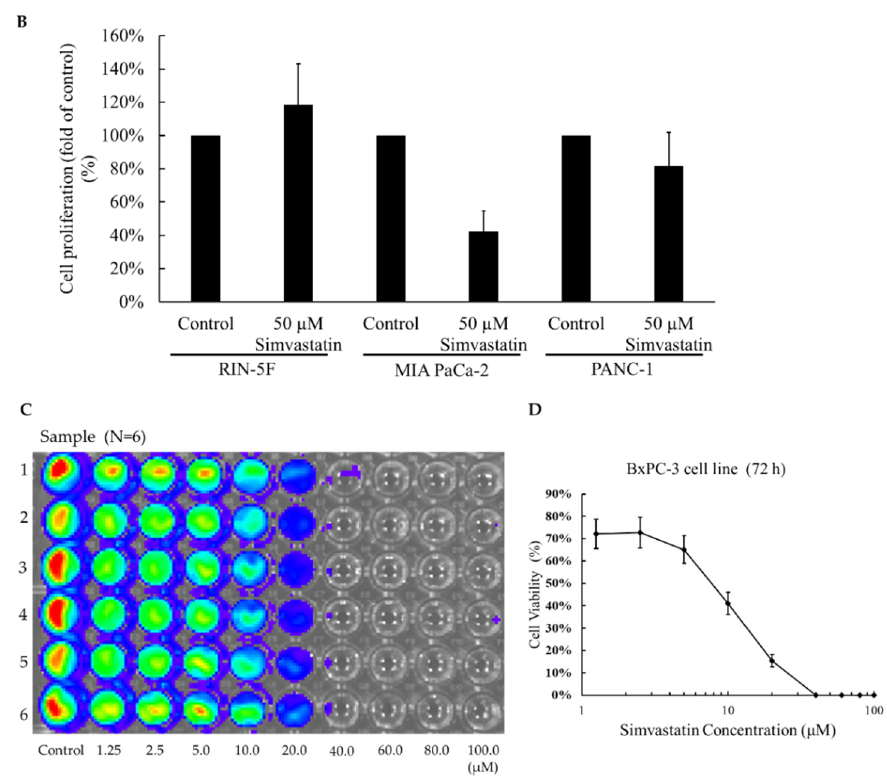
Figure 1. The pancreatic cancer cell viability after simvastatin treatment. ( A ) 50 μM simvastatin treatment significantly decreased the MIA PaCa-2 and PANC-1 cell viability. ( B ) Reduction of MIA PaCa-2 and PANC-1 cell proliferation after treatment with 50 μM simvastatin. ( C ) The cell viability assay after different simvastatin concentration treatment in BxPC-3 cells. ( D ) The cell viability curve after different simvastatin concentration treatment in BxPC-3 cells. ( n = 6) ** p < 0.01 when compared to the control group.